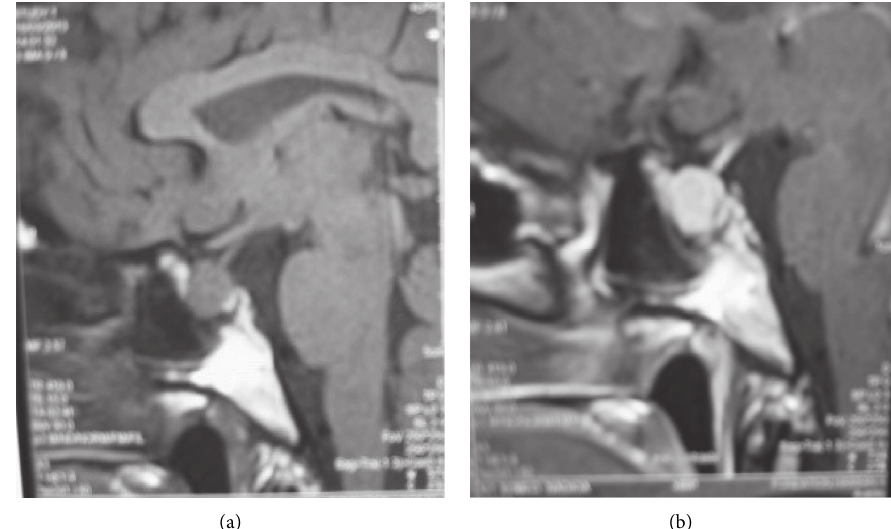
Figure 2: Preoperative pituitary MR images (T1-weighted, contrast, and sagittal view) showing (a) pituitary macroadenoma 12mm without mass effect on adjacent structures (especially optic chiasm) and (b) strong homogeneous enhancement of the pituitary adenoma after contrast